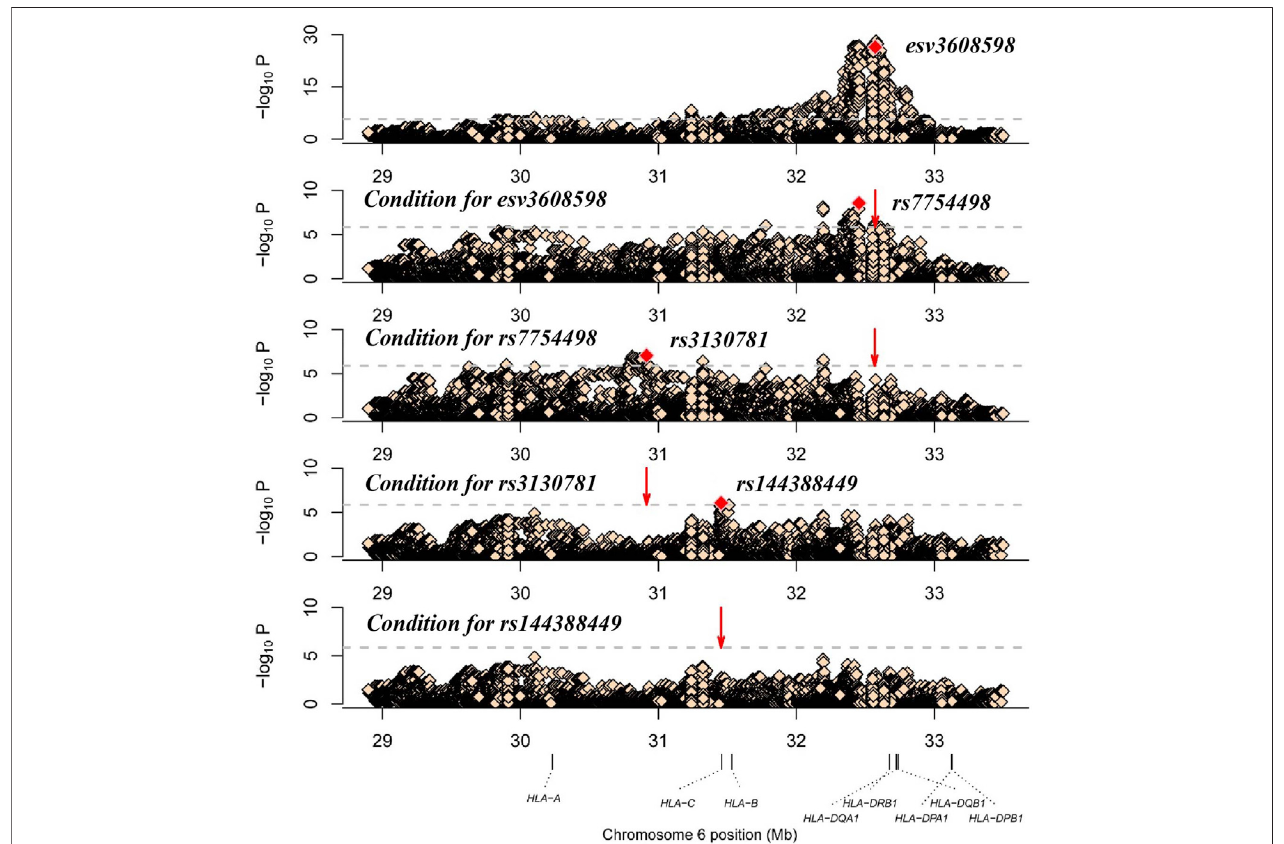
FIGURE 1 | Analysis of the HLA associated with leprosy. The x -axis shows genomic position and the y -axis shows – log10( p value) of the variants. The dashed horizontal line represents the signi fi cance threshold of p (cid:2) 1.39 × 10 − 6 . The dots marked red in each panel represent the sites used for condition analysis (esv3608598, rs7754498, rs3130781 and